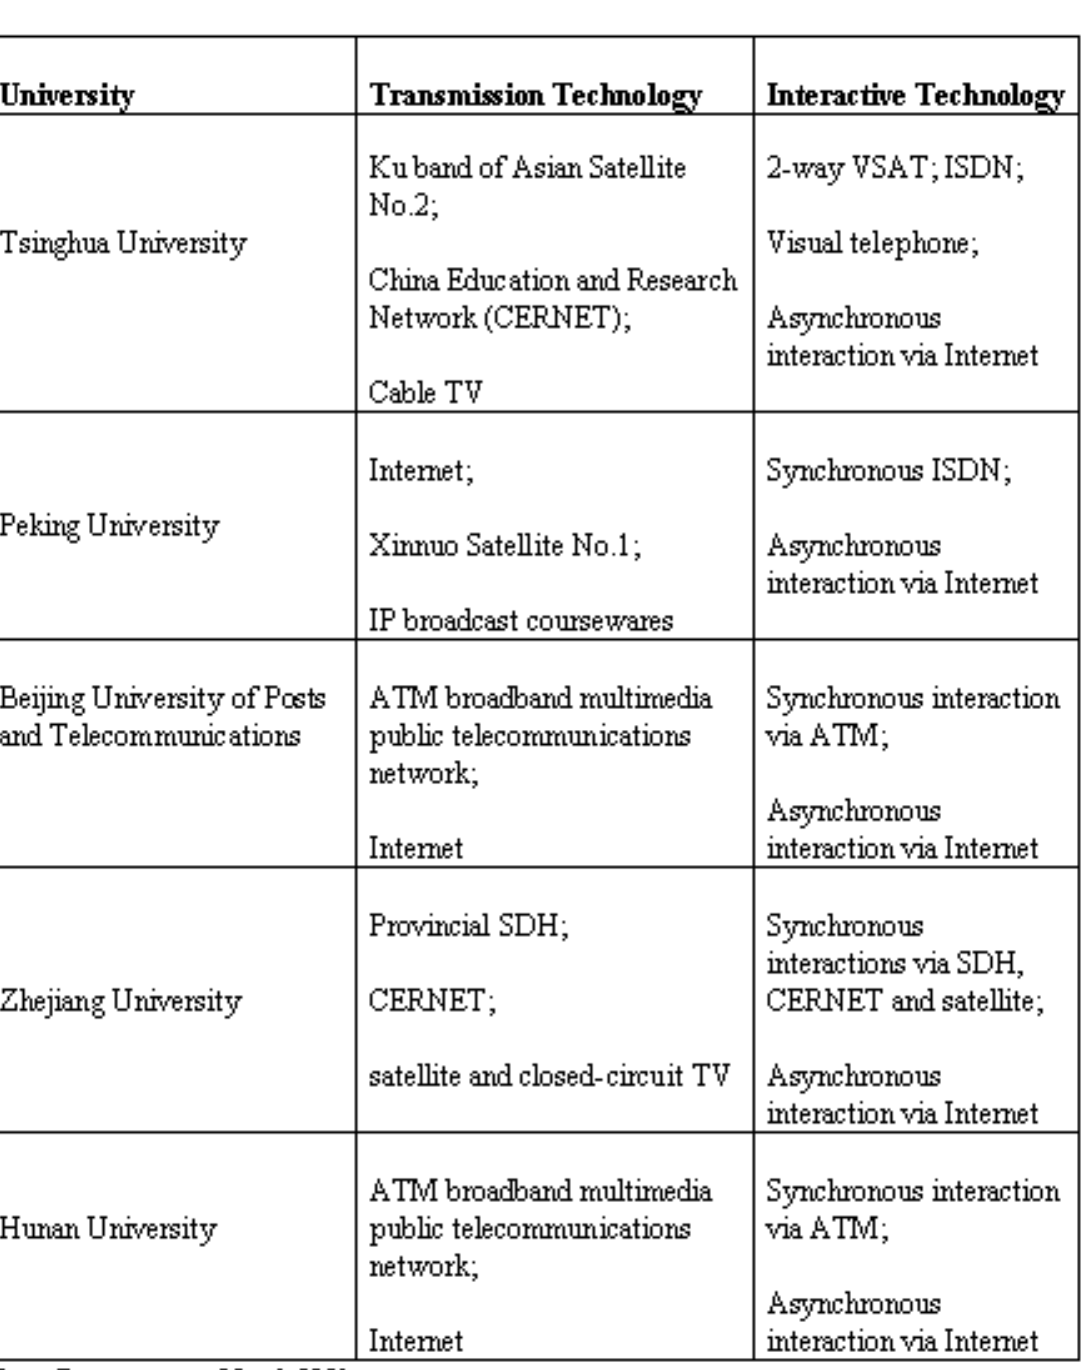
Table 6: Use of ICT for Web-based Educational